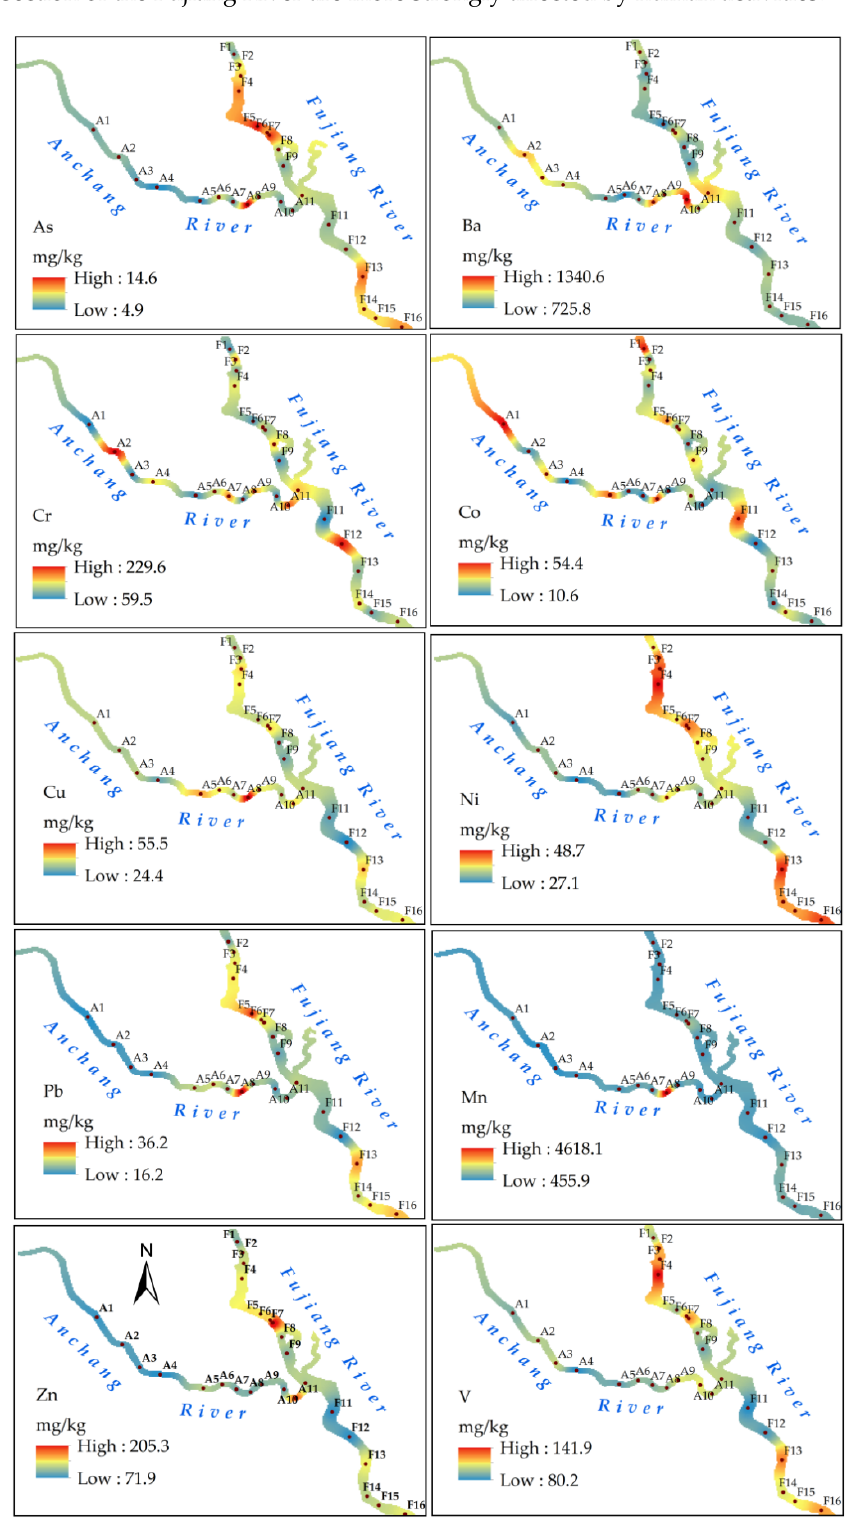
Figure 2. Spatial characteristics of HM concentrations in sediments of the Mianyang section of the Fujiang River. Fujiang